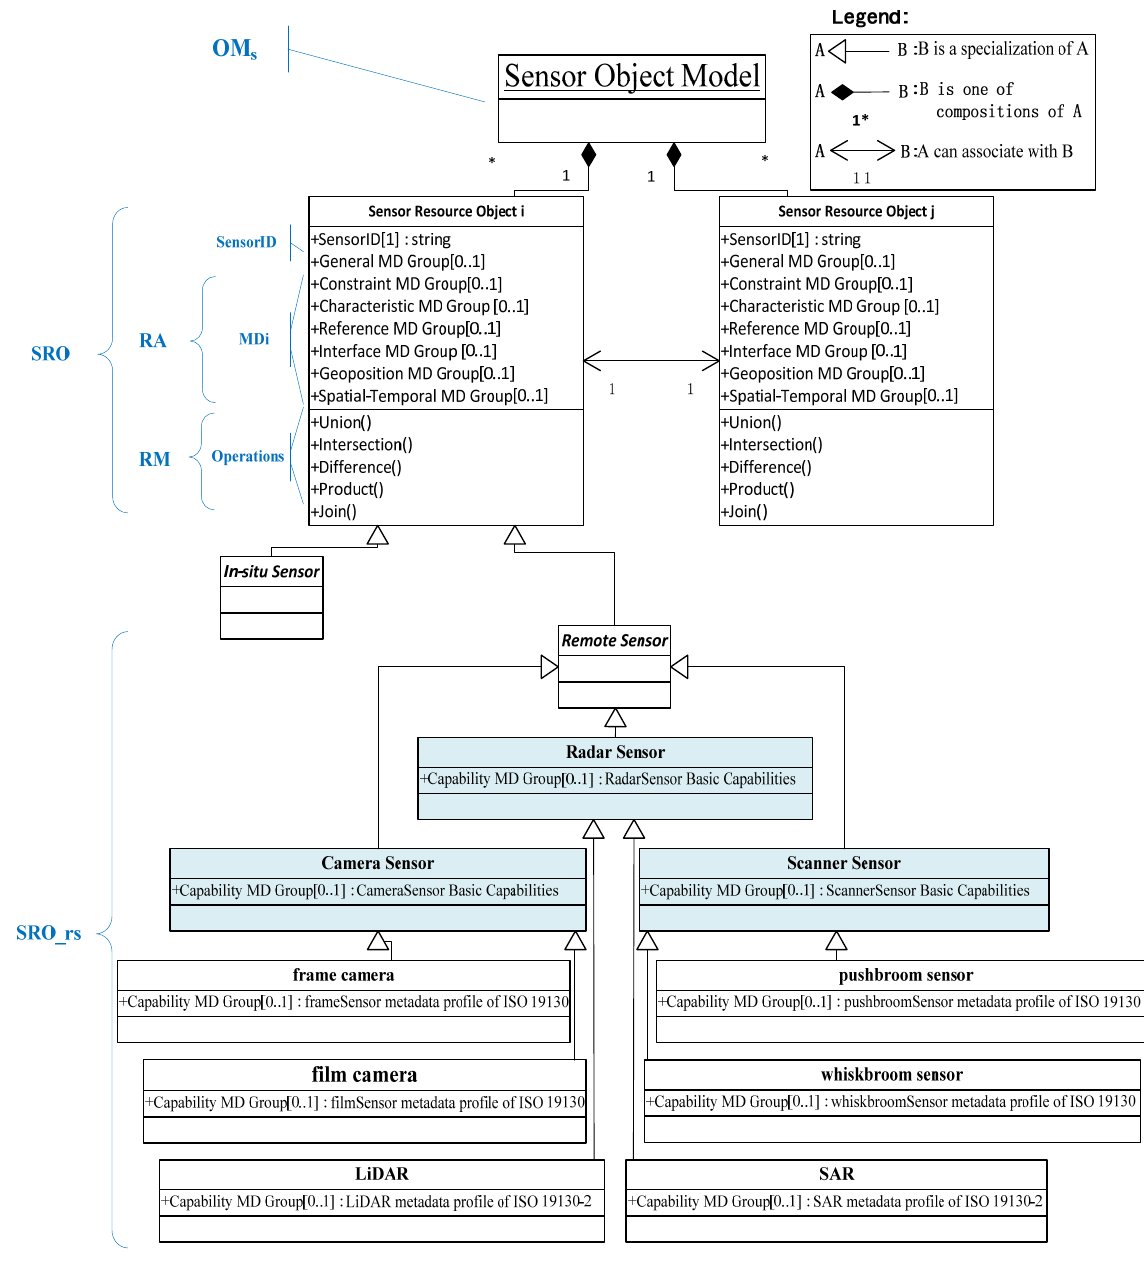
Figure 1. Conceptual level of the sensor object model (blue font are the corresponding